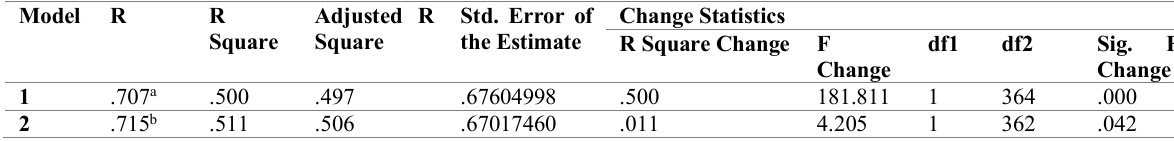
Table 3: Regression model summary for participative leadership style